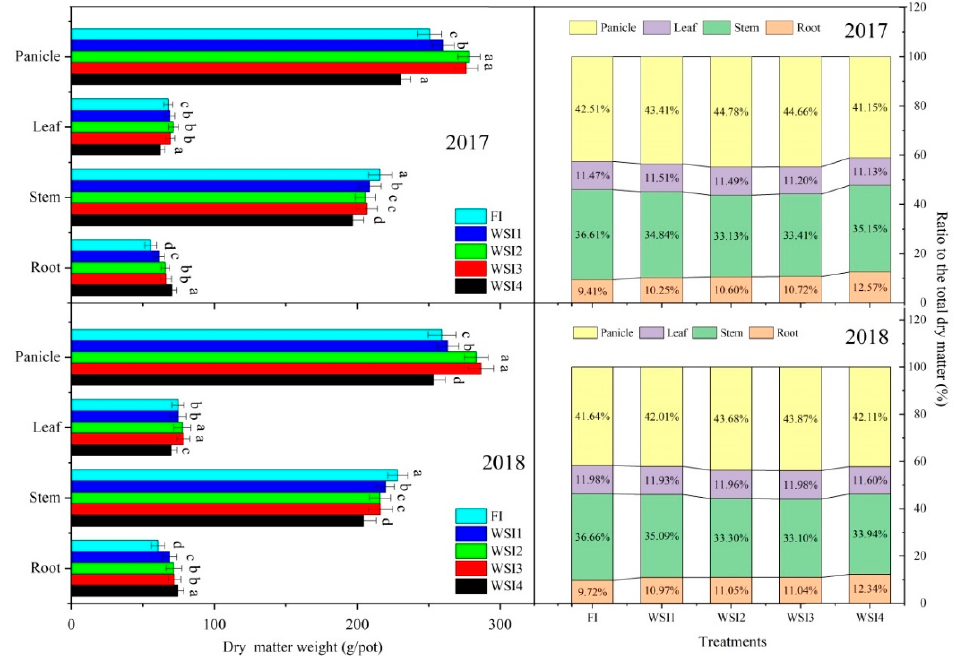
Figure 5. The dry matter yield of different parts of the rice plant and their ratio to the total dry matter weight in 2017 and 2018.